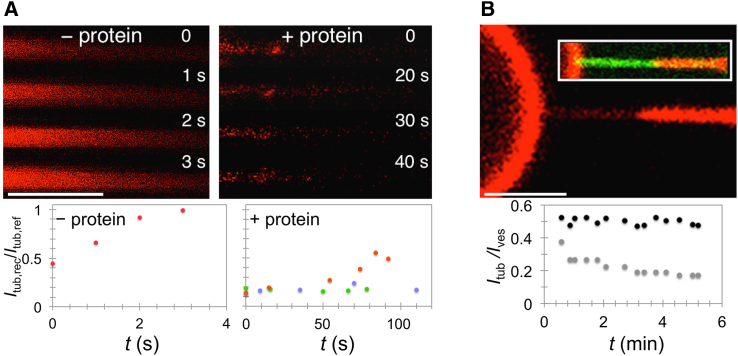
Protein Scaffold Forms a Lipid Diffusion Barrier(A) Confocal images after bleaching the bare tube (top left) and the protein-scaffolded tube (top right). Bottom: fluorescence intensity recovery of lipids in the scaffolded tube (Itub,rec) normalized by the prebleaching value (Itub,ref) as a function of time t of photo recovery. Plot colors represent different independent experiments. Scale bar, 3 μm.(B) Fluorescent image of a tube with coexisting scaffolded (thinner) and nonscaffolded (thicker) domains. Inset shows overlaid green (N-BAR domain) and red (lipid) channels. Graph shows the tube fluorescent intensity normalized by the vesicle intensity (Itub/Ives) on the nonscaffolded domain (black dots) and the calculation of what the tube radius would have been according to r=κ/2σv if tube tension were equilibrated (gray dots). During the experiment, σv was increased stepwise. The scaffold creates a diffusion barrier preventing a quick reduction in r of the unscaffolded part. Scale bar, 3 μm.